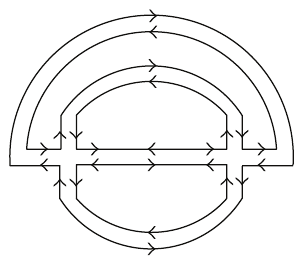
Figure 9: Connected diagram contributing to the correlation function (cid:12) Tr (cid:2)Φ 4 (cid:3) Tr (cid:2)Φ 4 (cid:3) (cid:13) .